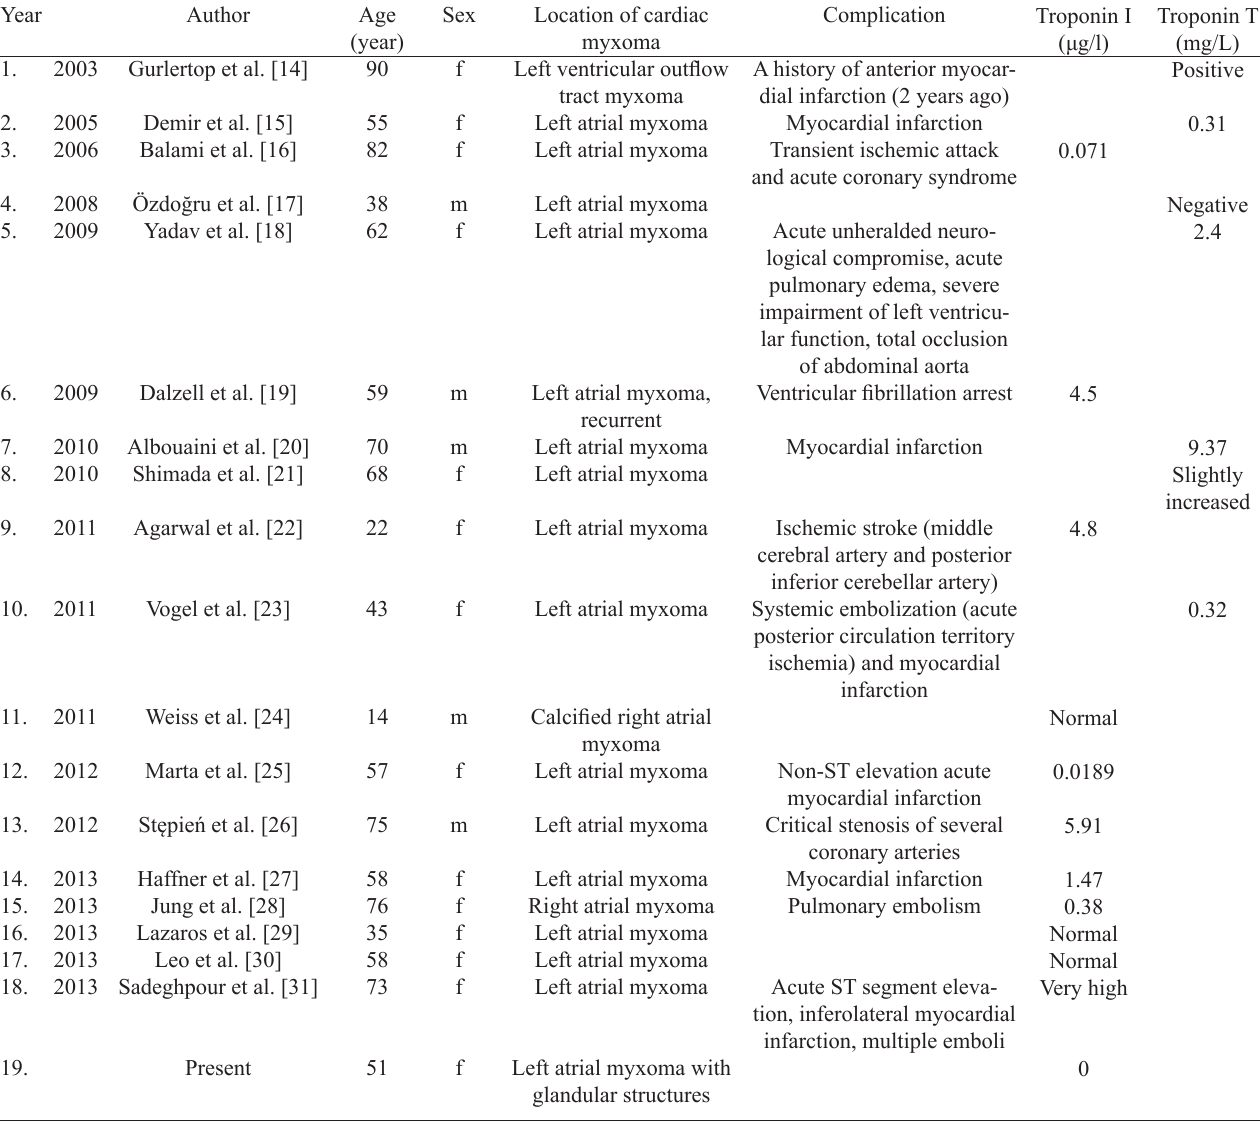
Table 2. Preoperative troponin levels in the patients with a cardiac